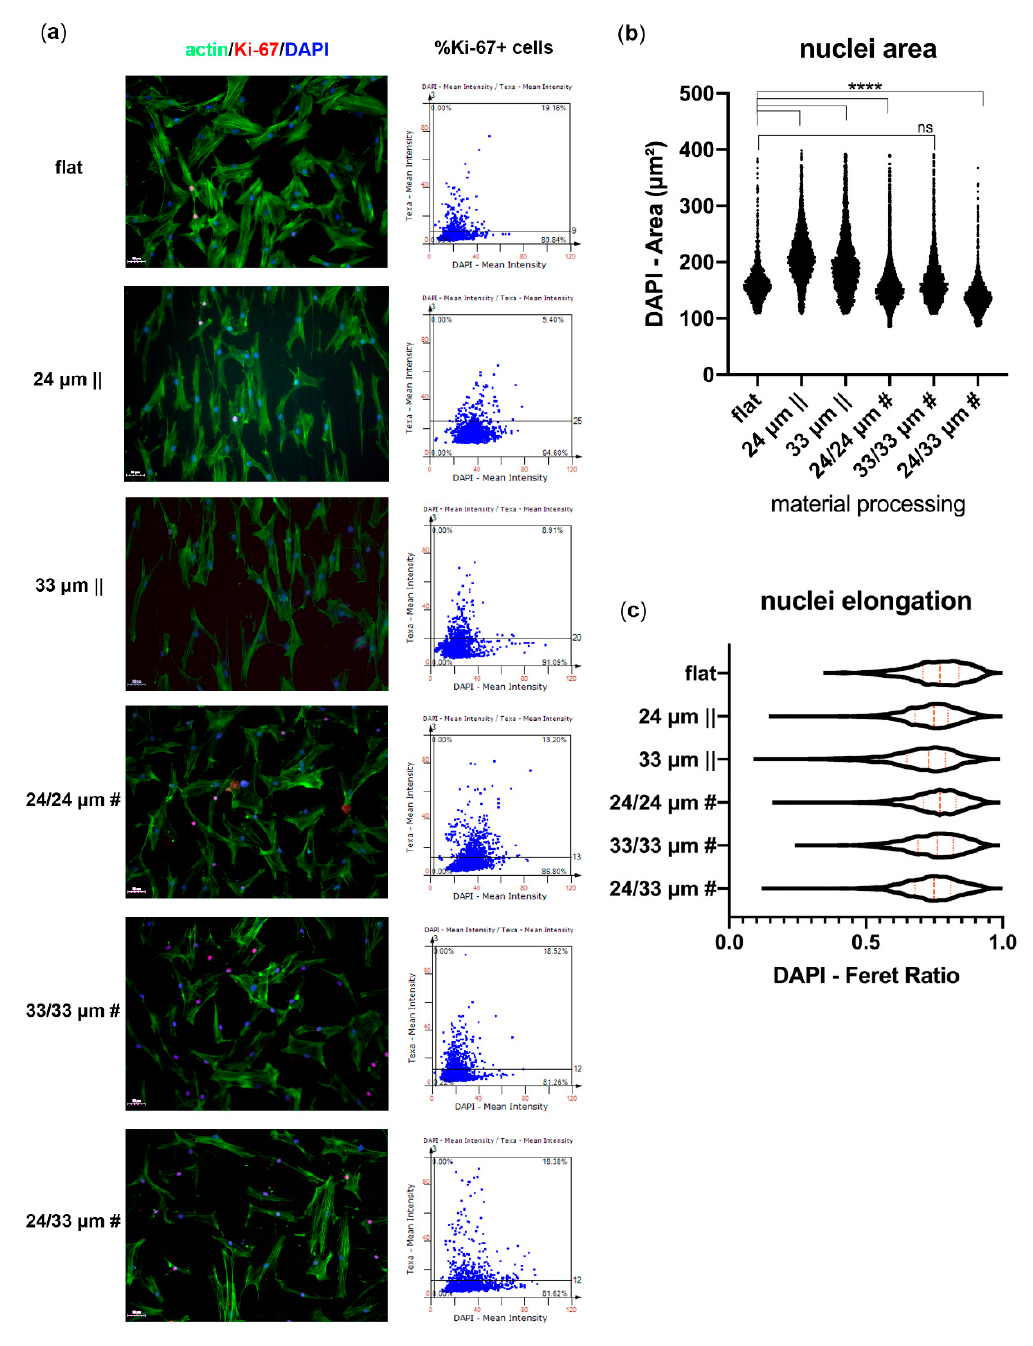
Figure 7. Proliferation of human mesenchymal stem cells (hMSCs) onto Zirconia microtopographies. Immunofluorescence microscopy images of Ki-67 + cell nuclei, and their corresponding image cytometry scatter plot quantification ( a ) at 3 days post-seeding onto the tested biomaterials. Nuclei area ( b ) and elongation ( c ) were analyzed for cell interaction with each of the structured Zirconia substratum. The fluorescence images ( a ) were obtained upon labeling with antibodies for Ki-67 (red) and staining of actin filaments with Alexa Fluor 488-Phalloidin (green) and nuclei with Hoechst (blue). Image acquisition was performed using the TissueFAXS iPlus automatic system. Data represent mean ± S.E.M., **** p < 0.0001.